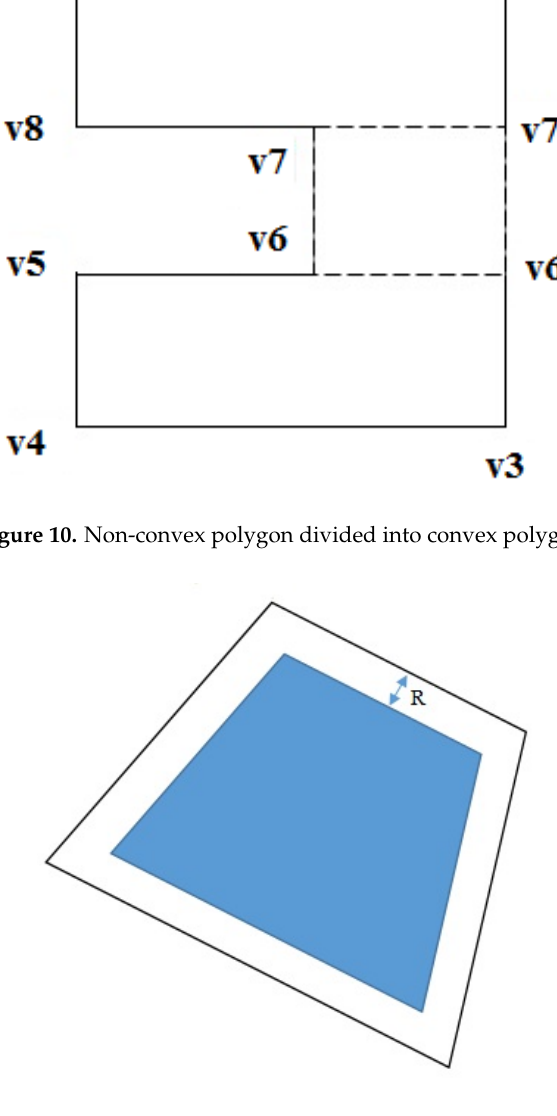
Figure 11. Polygon expansion: R is safe constant